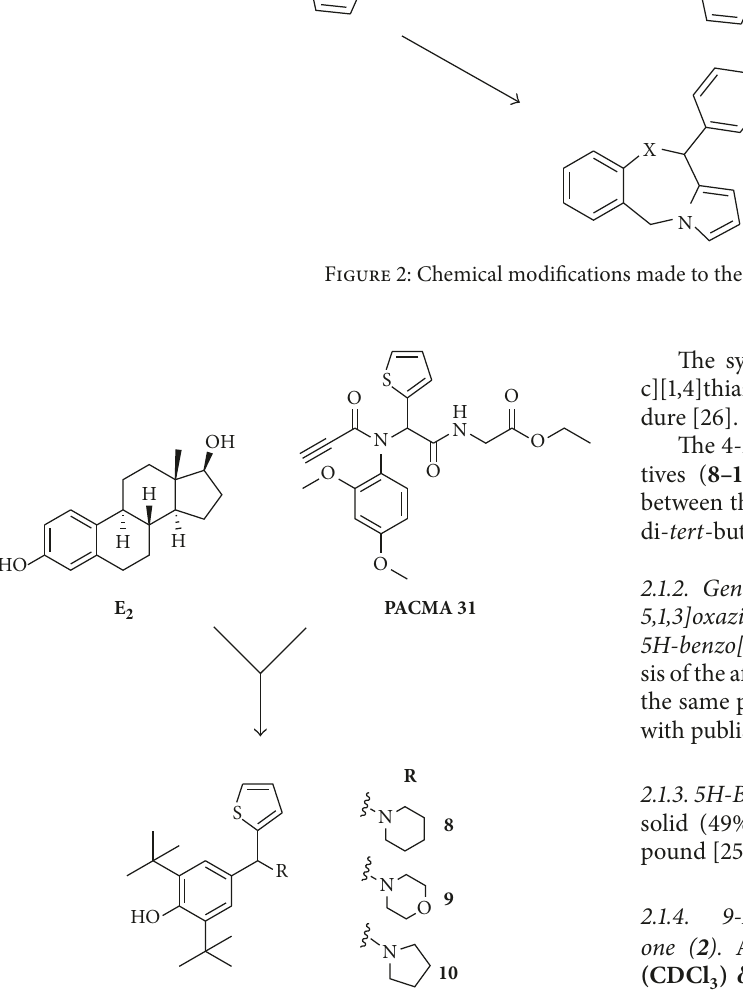
Figure 3: Design of a new class of PDI